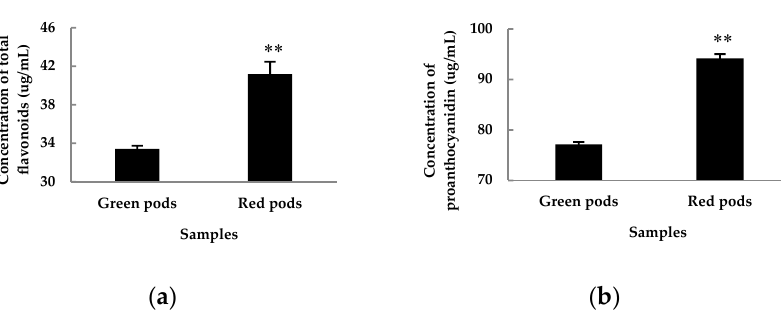
Figure 3. Concentration of total flavonoids ( a ) and proanthocyanidin ( b ) in 30-day-old red and green pods after anthesis. The values are the averages of three biological duplicate samples. ** indicates significant difference between samples at p < 0.01 level using Student’s t -test.